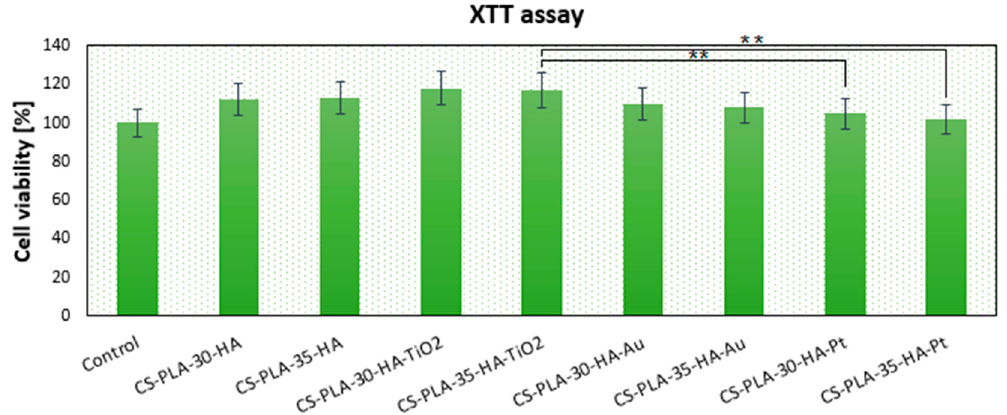
Figure 9. Metabolic activity of osteosarcoma MG-63 cells after seven days of in vitro cell culture determined by XTT assay, (** p < 0.01).